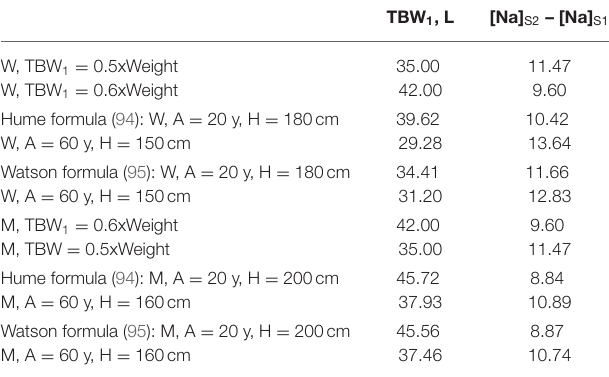
TABLE 2 | Body water estimates and rise in serum sodium computed by the Adrogué-Madias formula in subjects with initial serum sodium of 100 mmol/L receiving an infusion of 1L of 3% saline (513 mmol of